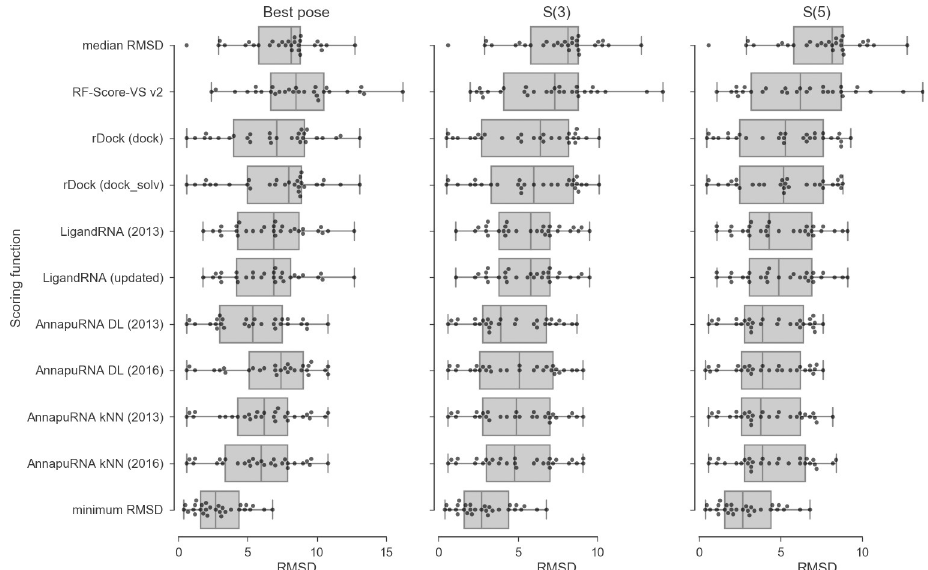
Fig 2. Comparison of the performance of nine scoring functions, expressed as the RMSD between the best-scored pose and the reference pose (left panel), best among the top three scored poses ( S (3), middle panel), and best among the top five scored poses ( S (5), right panel). Additional rows represent the median and minimal values of RMSD obtained during docking. Each dot represents one complex from the testing set. Docking was performed using rDock with dock desolvation potential with the native conformation of a ligand as an